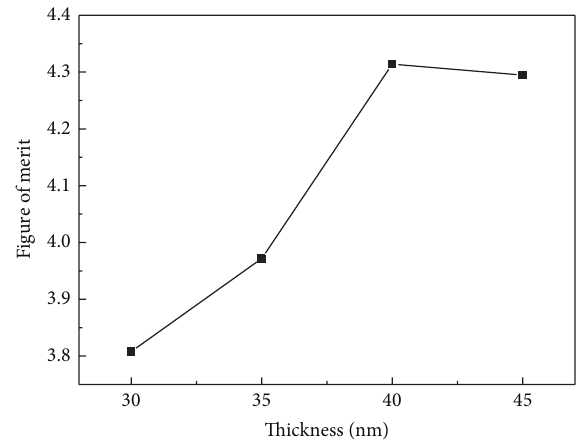
Figure 4: Figure of merit of the triangular Ag nanoparticle arrays with different Ag layer